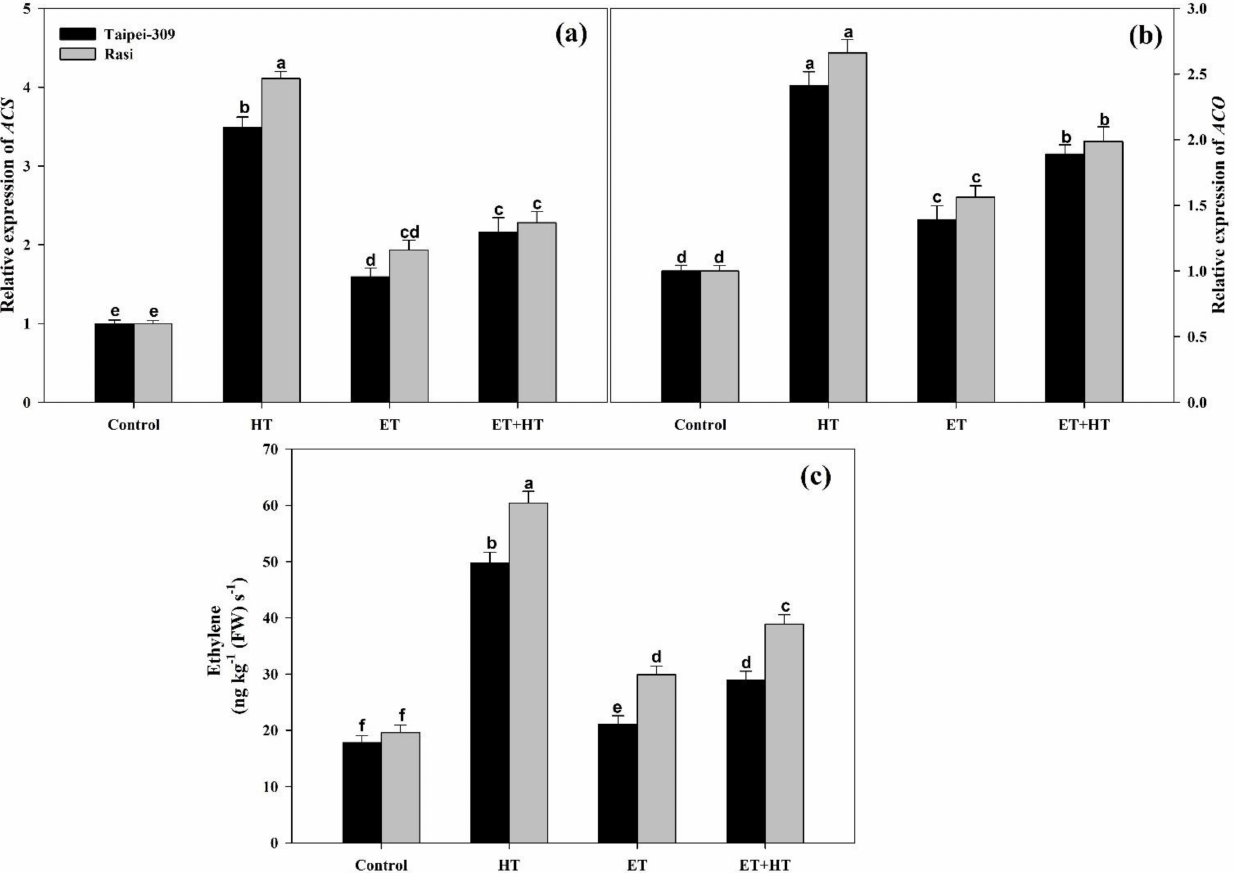
Figure 7. Relative expression of ACS ( a ) and ACO ( b ), as well as ethylene evolution ( c ), in Taipei- 309 and Rasi cultivars of rice ( Oryza sativa L.) at 30 DAS. Plants were grown with/without high- temperature (HT) stress and treated with a foliar spray of 1.6 mM ethephon (ET) at 15 DAS. Data are presented as treatment means ± SE ( n = 4). Bars with the same letters did not differ significantly by the LSD test at p < 0.05. ACS , 1-aminocyclopropane carboxylic acid synthase; ACO , 1-aminocyclopropane carboxylic acid oxidase; DAS, days after